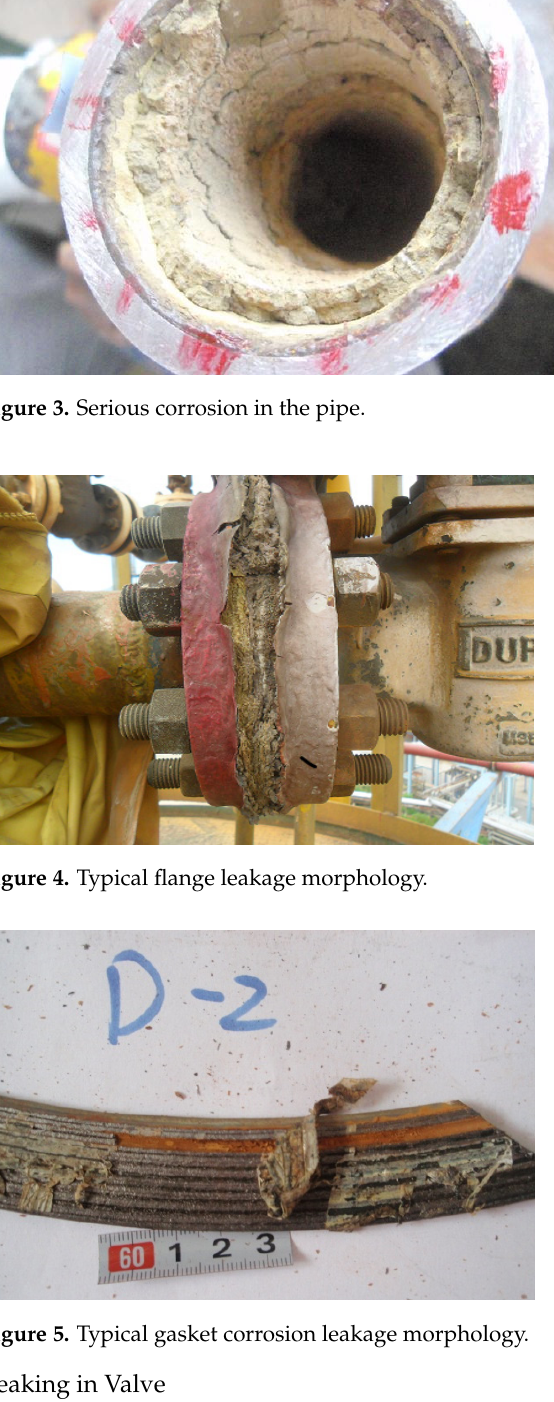
Figure 5. Typical gasket corrosion leakage morphology.